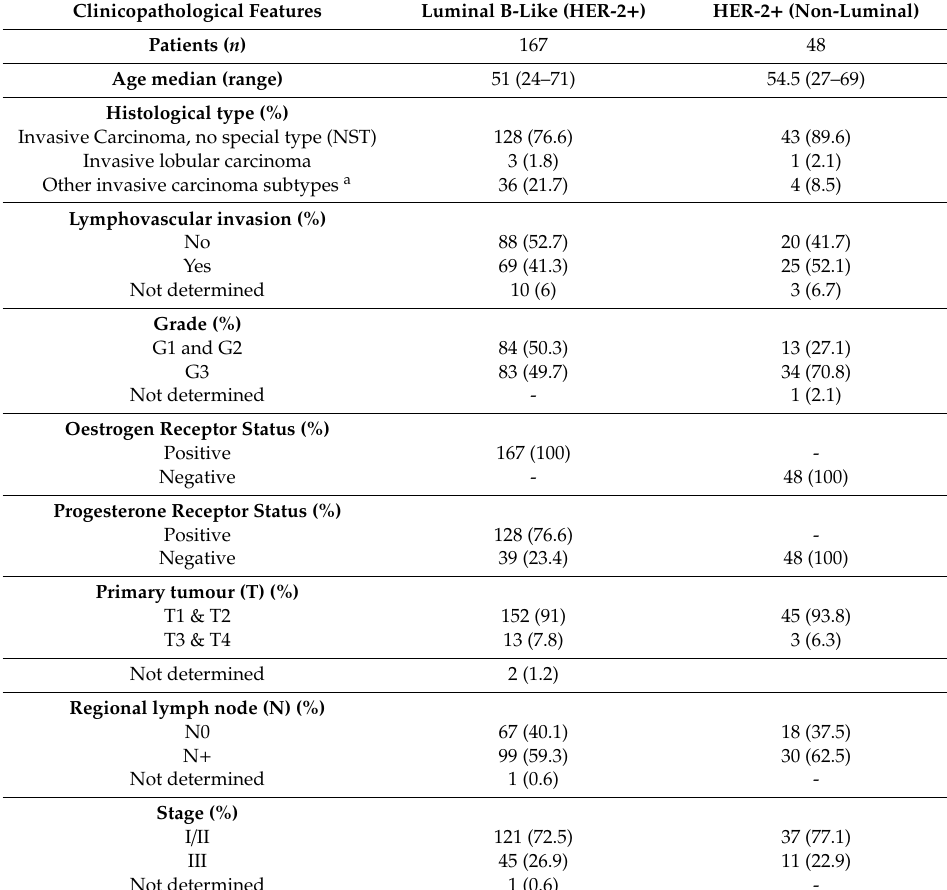
Table 2. Clinical and pathological features of luminal-B like (HER-2 + ) and HER-2 + (non-luminal) breast cancer (BrC) patients enrolled in the study.